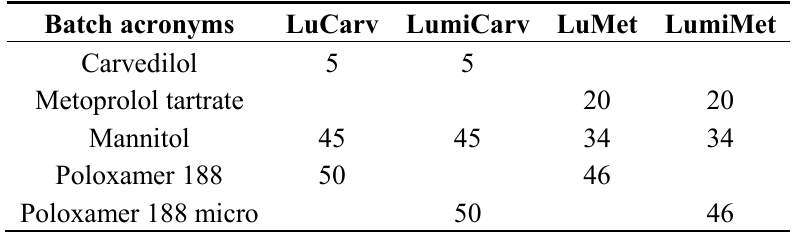
Table 3. Composition of melt-extrudate batches